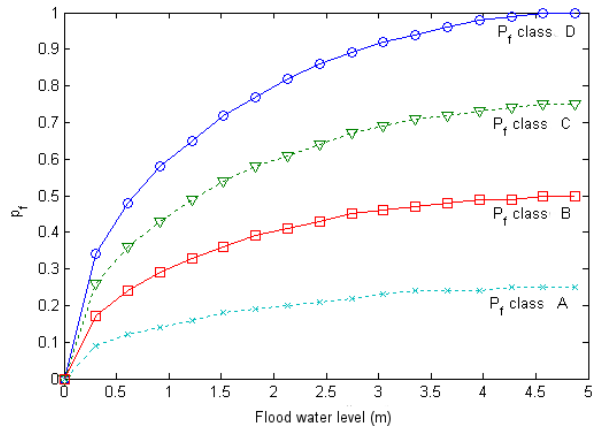
Fig. 3. Evolution of damage risk P f according to the flood water level